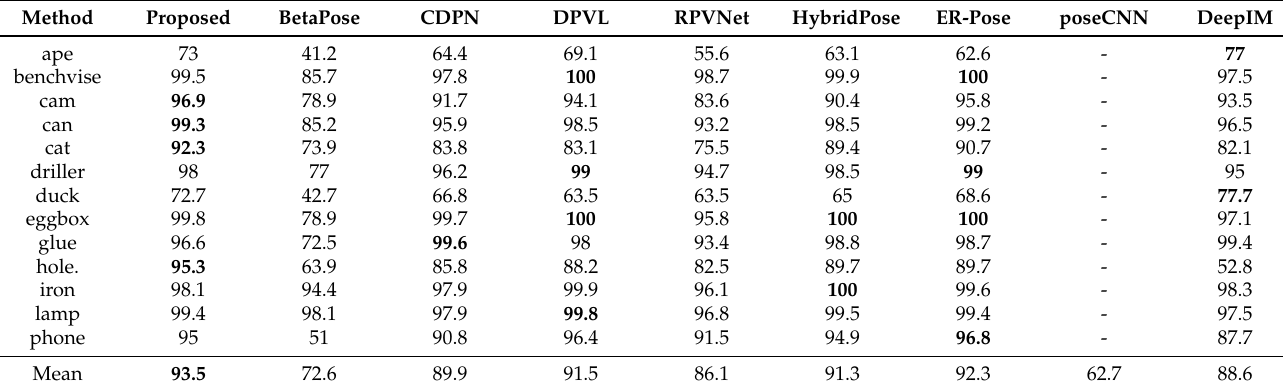
Table 3. Comparison of methods on the LINEMOD dataset in terms of the ADD(-S) metric.